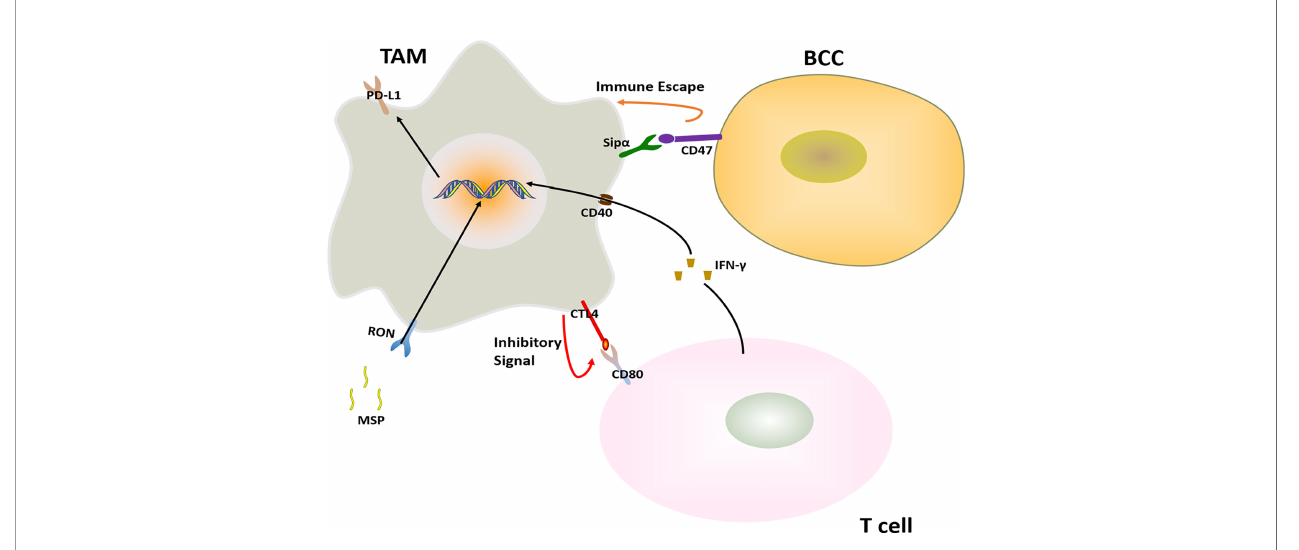
FIGURE 5 | Major mechanisms of immunotherapy resistance in BC in connection with TAMs. The immunotherapy resistance is also associated with T